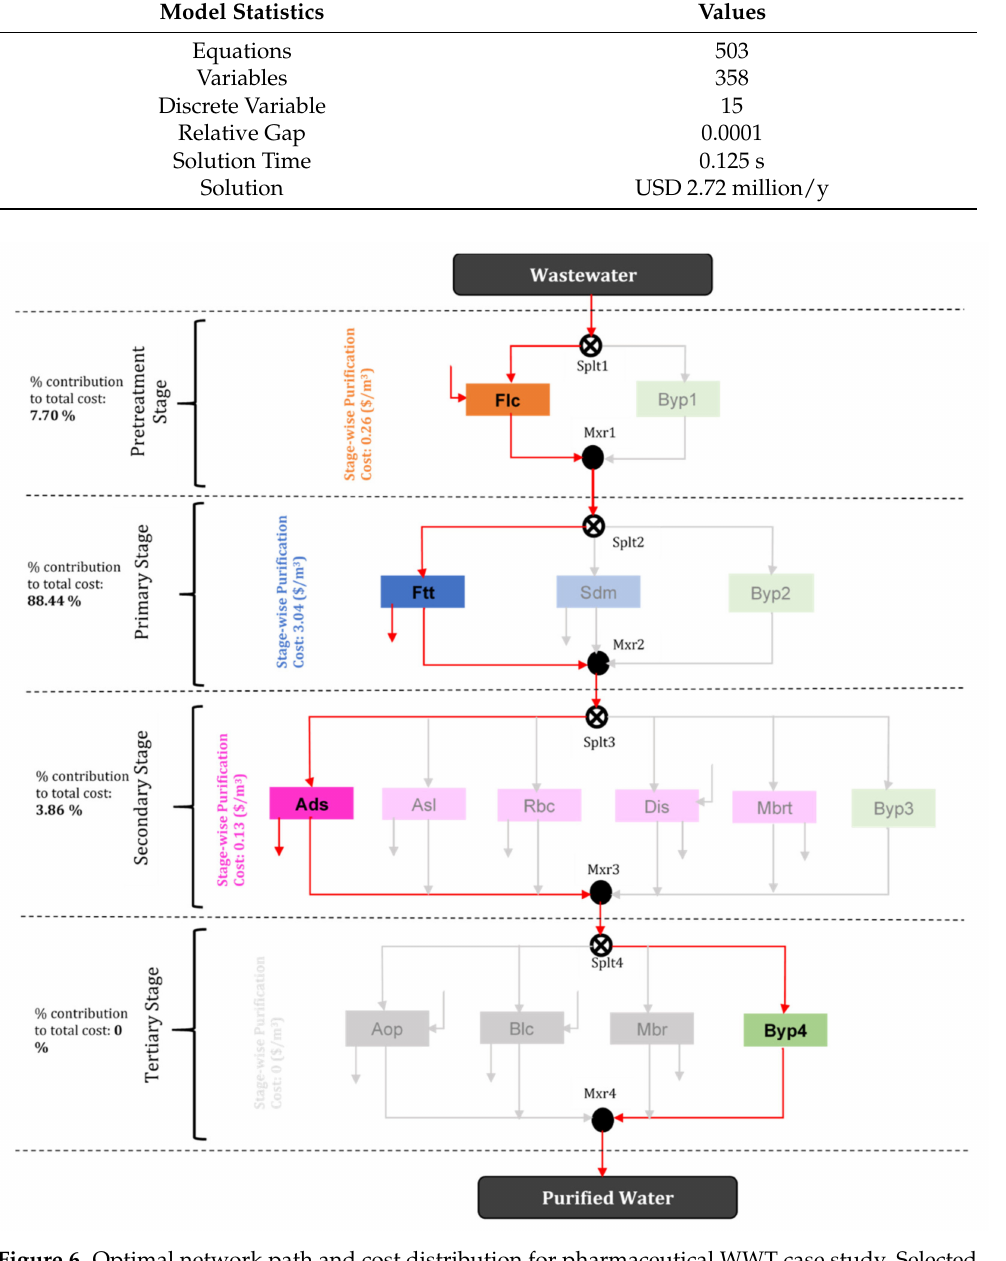
Figure 6. Optimal network path and cost distribution for pharmaceutical WWT case study. Selected technologies are flocculation (Flc), filtration (granular) (Ftt), and adsorption